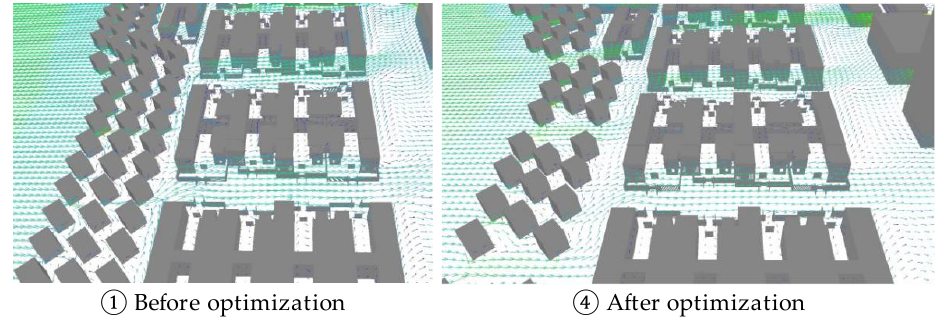
Figure 7. Wind direction diagram before and after optimization (Shows the flow path variation of ① ④ ventilation).